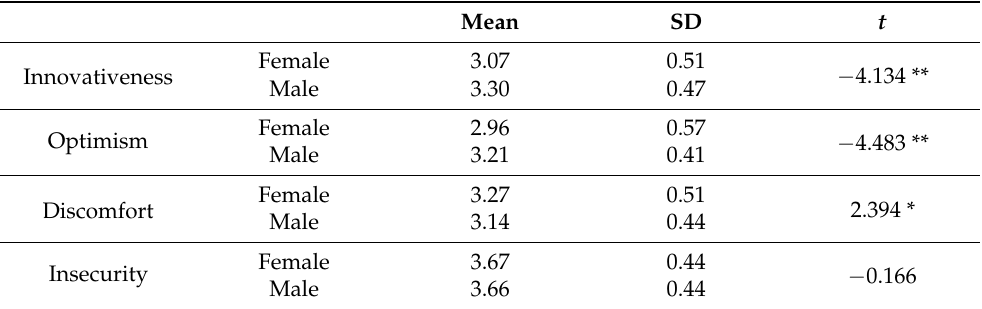
Table 4. Results of independent t-test